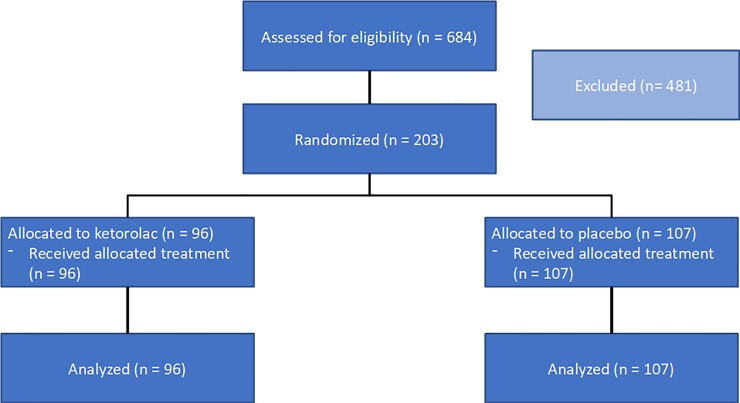
CONSORT diagram.